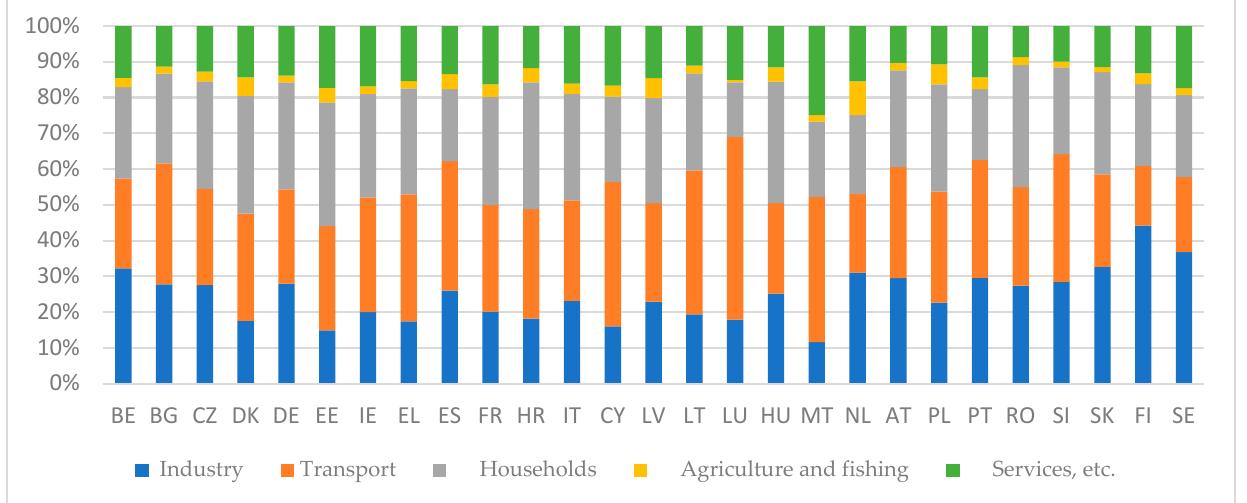
Figure 5. Structure of energy consumption in EU countries by sectors (shares of total consumption in the country, 2020). Source: Own elaboration based on Eurostat 2022.